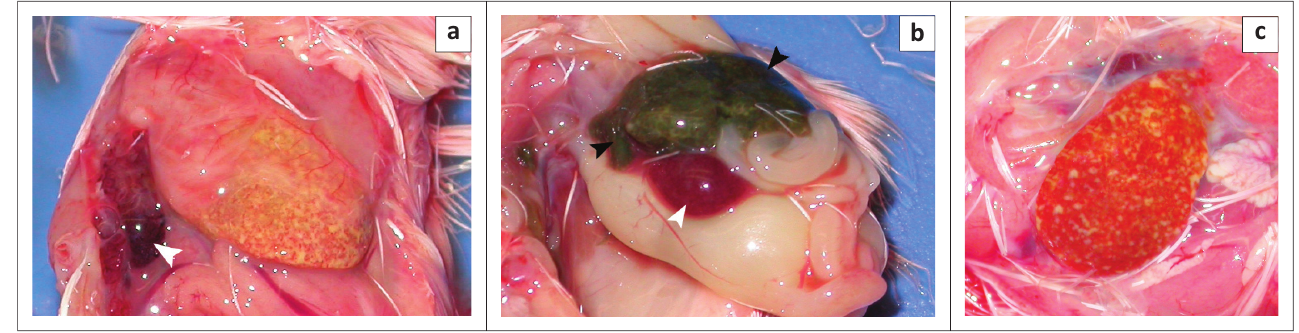
FIGURE 1: Histological changes seen in the (a) liver, (b) spleen and (c) kidney of infected chicken embryos.